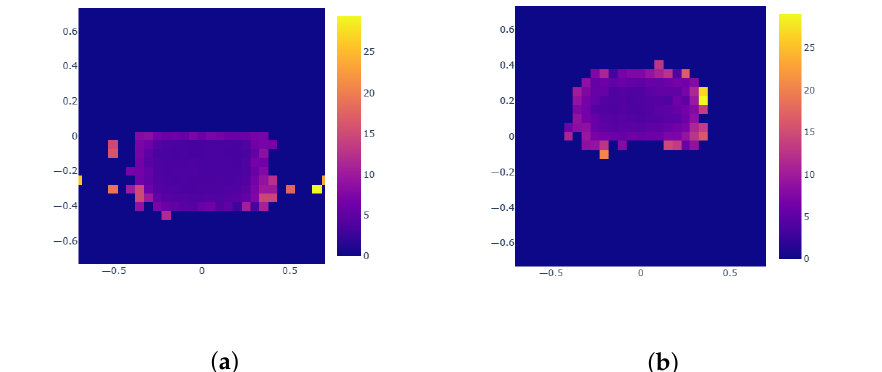
Figure 10. The data distribution of gaze direction on the two datasets: ( a ) MPIIFaceGaze [20]; ( b ) Eyediap [42]. The yaw of the gaze direction is recorded on the horizontal axis, and the pitch of the gaze direction on the vertical axis. The brighter the color of the heatmap, the more concentrated the gaze direction.